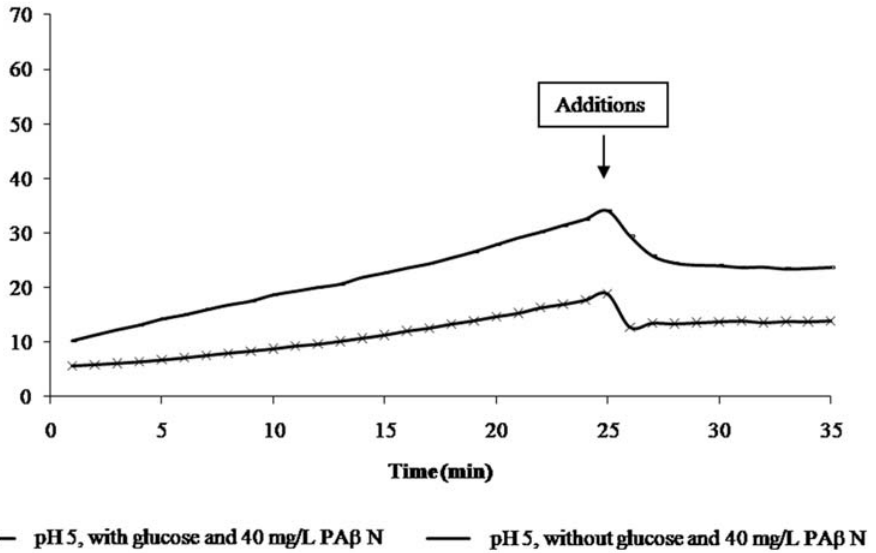
Figure 4. Effects of PA b N on efflux of EB by AG100 TET at pH 5 and 8. The same protocol of accumulation was followed as for figure 2. After 25 minutes media with glucose and PA b N was added to the